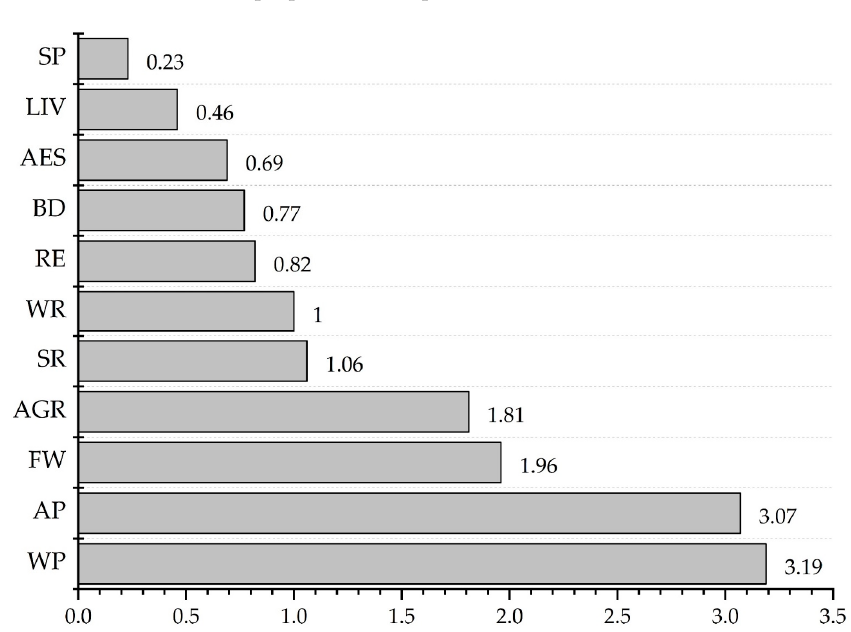
Figure 2. The proportion of respondents who chose ES and BD.